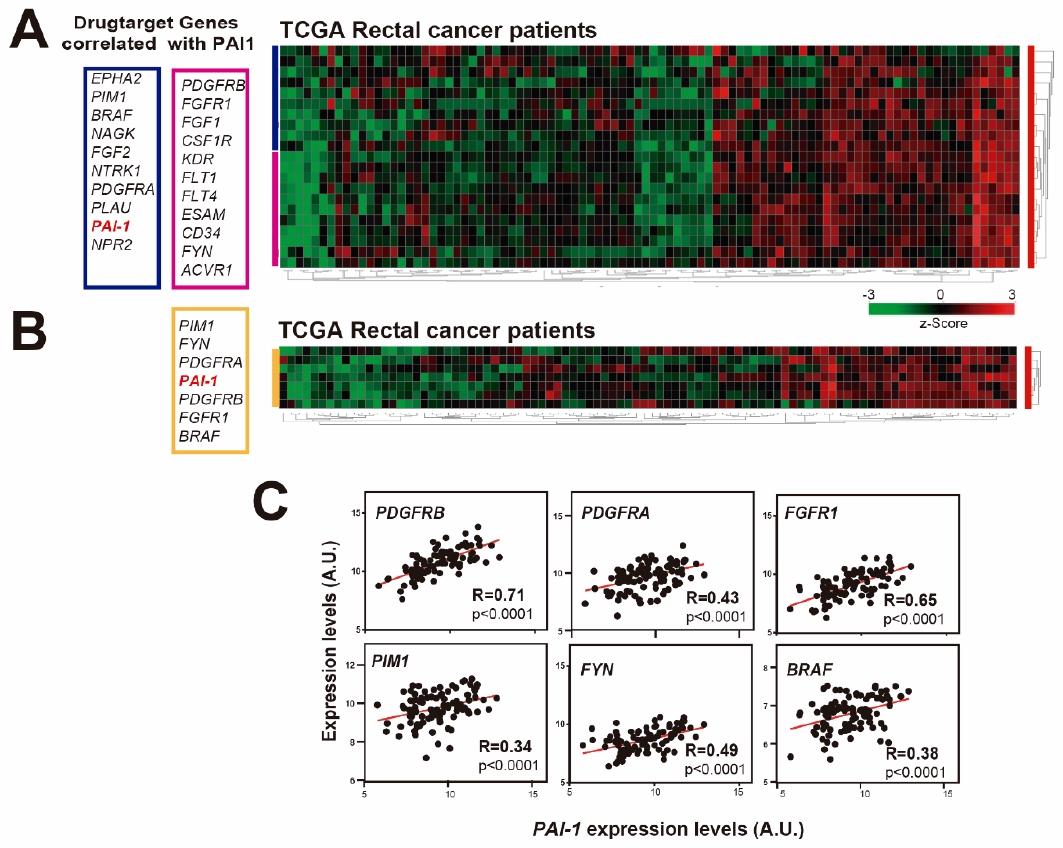
Figure 4. PAI1 expression correlates with drug target genes in rectal cancer patients. ( A ) Heatmap showing the expression z-scores of drug target genes that correlate with PAI1 in the TCGA rectal cancer patient database. ( B ) Heatmap showing the z-scores of the most significant drug target genes that correlated with PAI1 in the TCGA rectal cancer patient database. ( C ) Correlation of the expression levels of the drug targets genes PDGFRa, PDGFRb, FGFR1, PIM1, FYN and BRAF with the expression levels of PAI1 in the TCGA rectal cancer patient databases. Data were analyzed using Pearson´s R correlation. The proto-oncogene serine / threonine-protein kinase PIM1 (R = 0.34, p < 0.0001; Figure